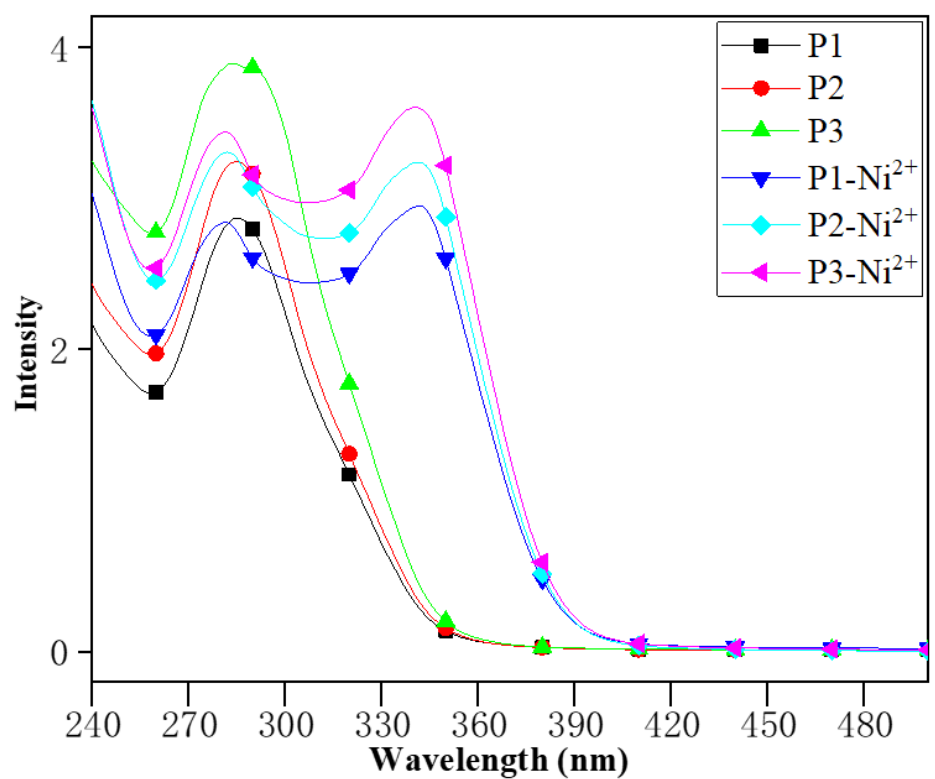
Figure 3. UV spectra of 33 ppm P1 (7% terpyridine content), P2 (10% terpyridine content), and P3 (13% terpyridine content); and 33 ppm P1 , P2 , and P3 with 5 ppm, 7 ppm, and 9 ppm Ni 2+ in aqueous solution, respectively.